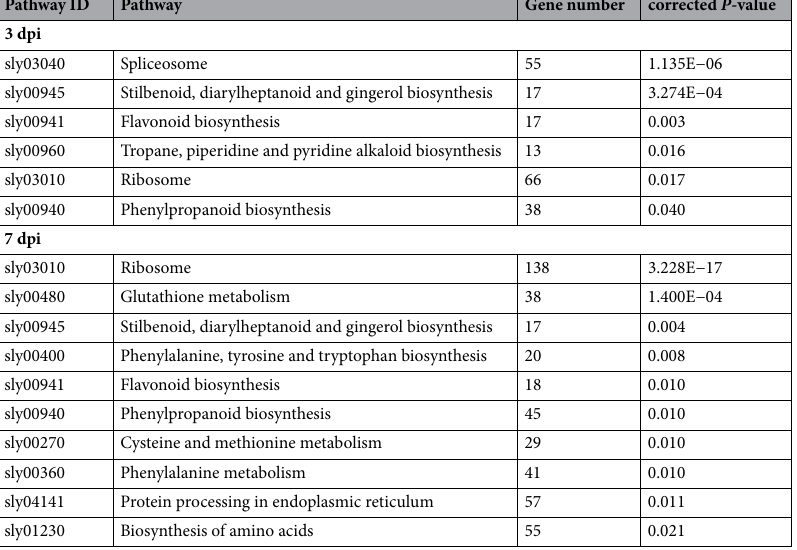
Table 2. The up-regulated KEGG pathways in resistant cultivar inducing by R. solanacearum infection.